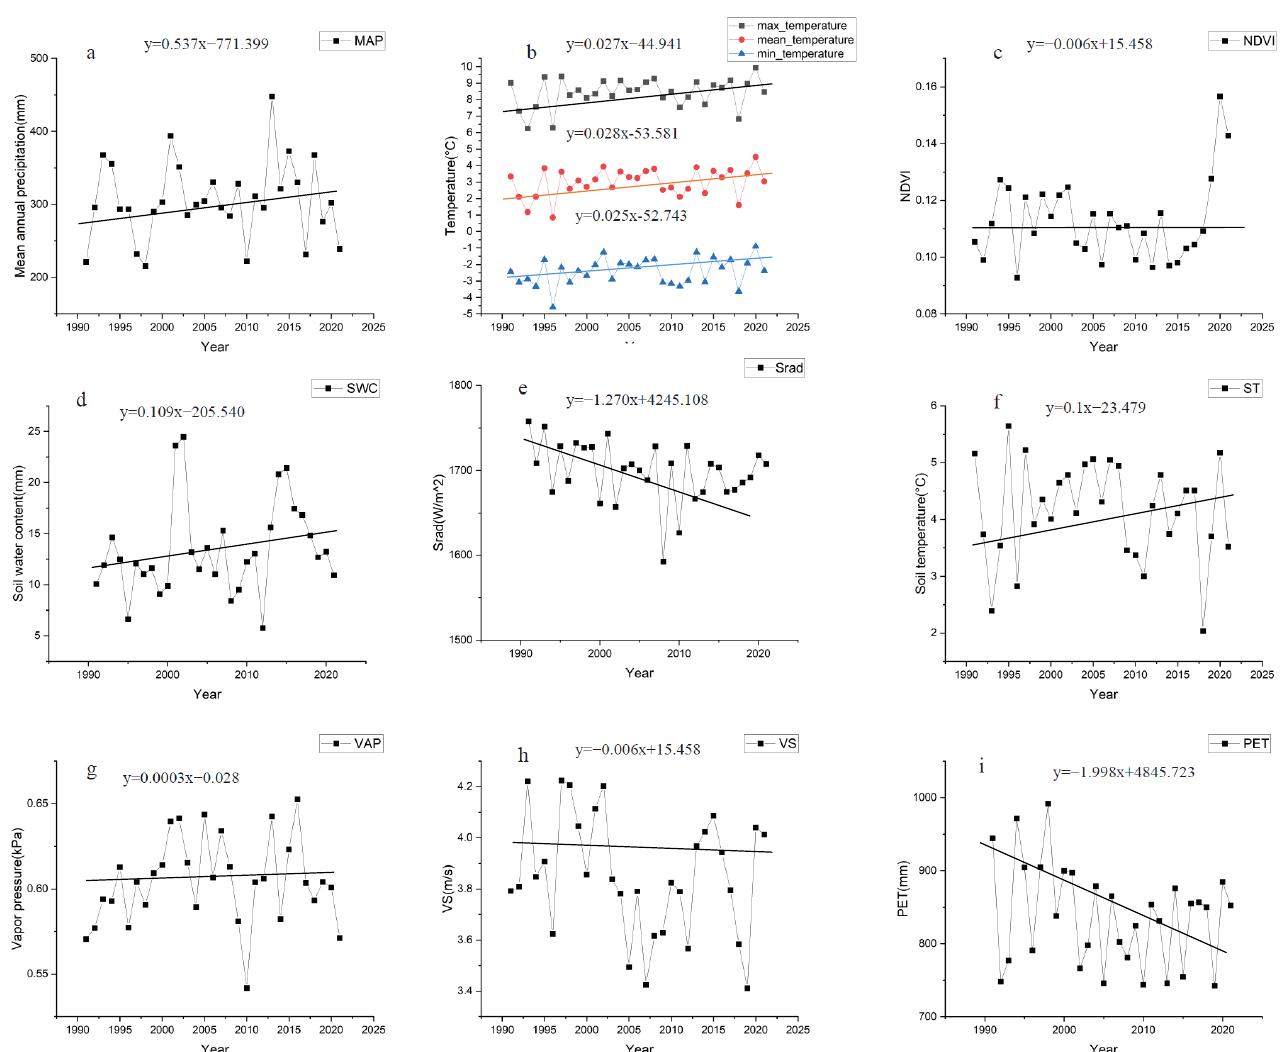
Figure 4. Environmental variables: ( a ) average annual precipitation; ( b ) average annual tempera- ture, annual maximum temperature and annual minimum temperature; ( c ) NDVI; ( d ) soil water content; ( e ) solar radiation; ( f ) soil temperature; ( g ) differential vapor pressure; ( h ) wind speed; and ( i ) potential evapotranspiration during 1991 – 2021.